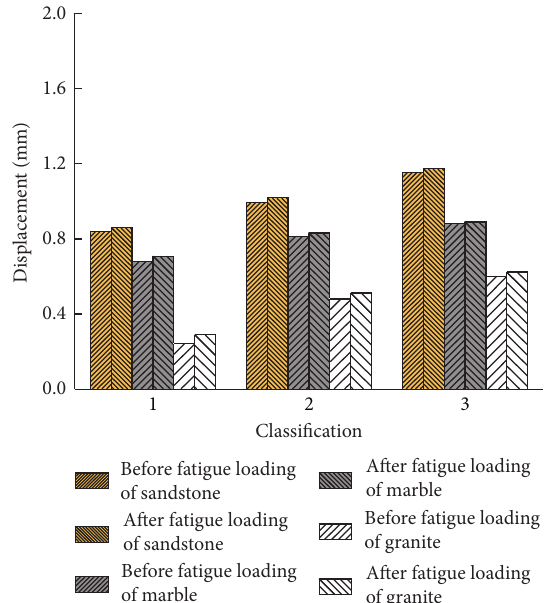
Figure 6: Bar chart of creep before and after fatigue loading.